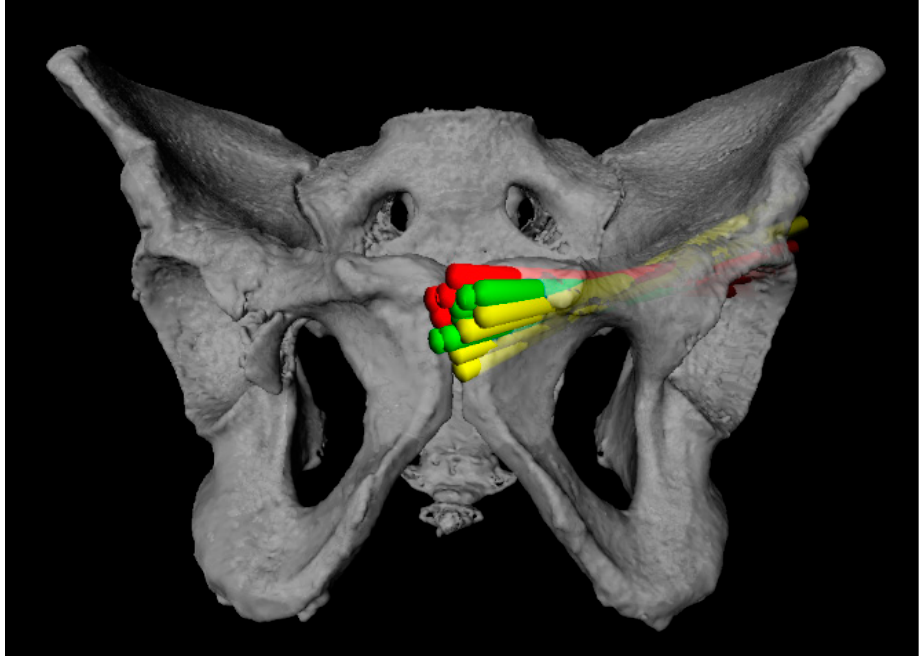
Figure 2. As many screws as possible were placed per case. Green screws were positioned correctly. Yellow screws had an entry point that was deemed surgically dangerous. Red screws exited the OFP prematurely.